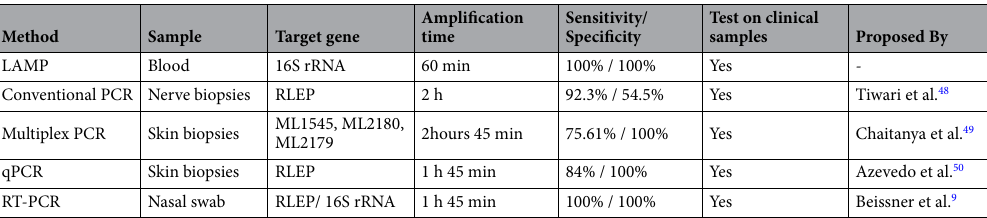
Table 3. Comparison of LAMP with PCR-based techniques.